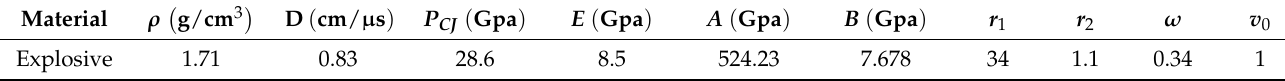
Table 2. Material parameters for 8701